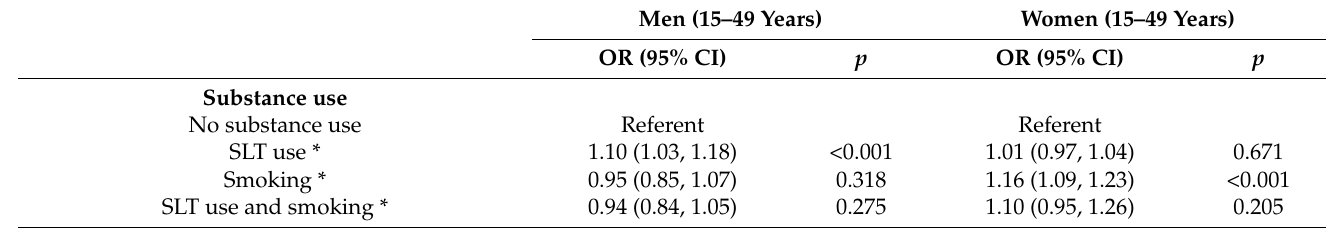
Table A1. Results of multivariate binary logistic regression analysis for hypertension among Indian men and women aged 15–49 years, India,